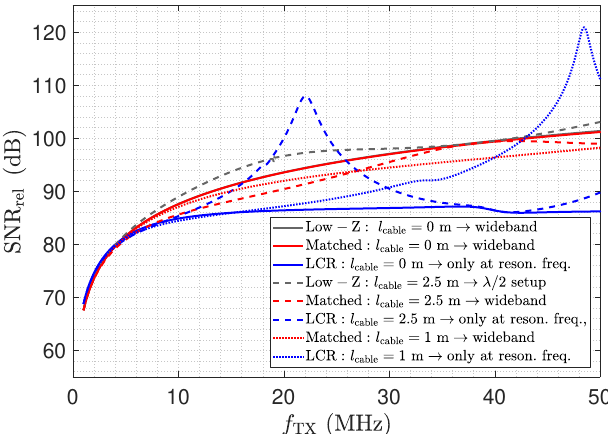
Figure 30. Comparison of SNR rel for the different receivers